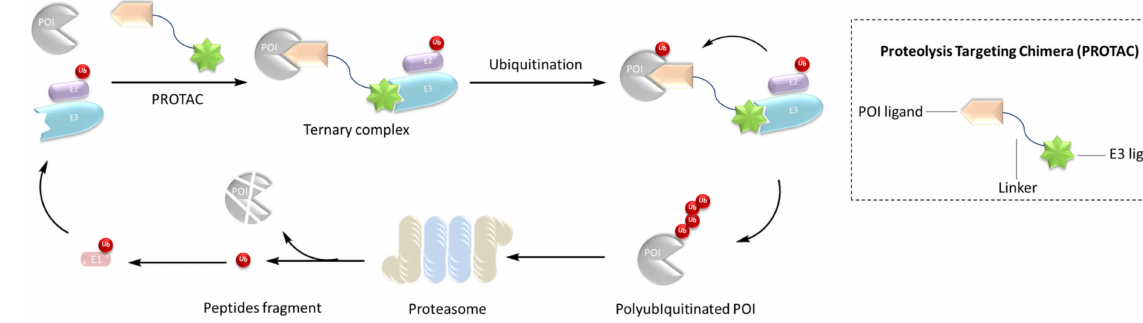
Figure 1. Mechanism of PROTAC.